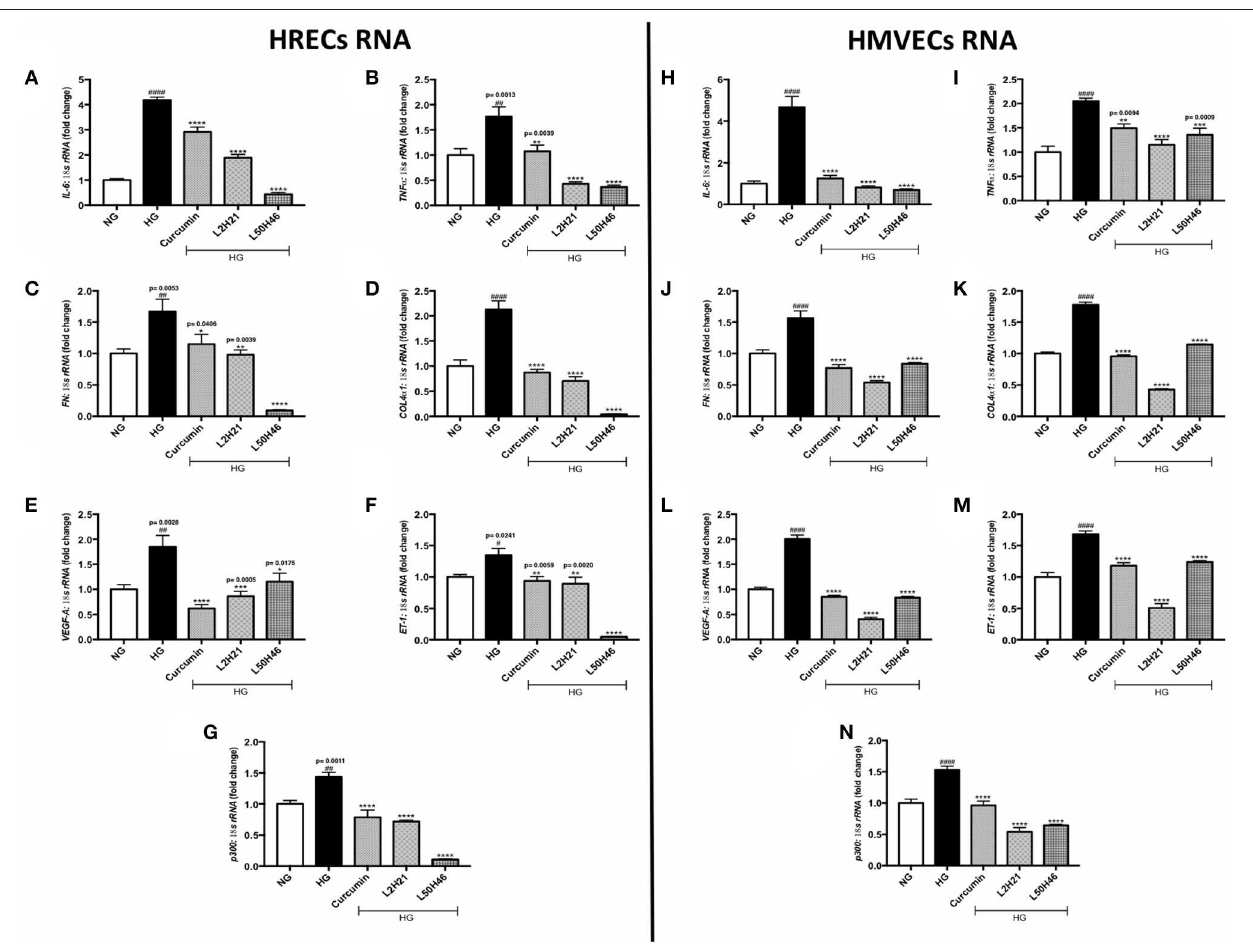
FIGURE 1 | Curcumin analogs significantly reduced gene expressions associated with glucose-induced vascular damage in vitro. Left panel: RT-qPCR analyses showing increased mRNA levels of (A) IL-6 , (B) TNF- α , (C) FN , (D) COL4 α 1 , (E) VEGF-A , (F) ET-1 , and (G) p300 in HRECs exposed to HG for 48h. The administration of curcumin or its analogs (1-h pre-treatment) was able to dampen the glucose-induced levels of these transcripts. Right panel: RT-qPCR analyses showing elevated mRNA levels of (H) IL-6 , (I) TNF- α , (J) FN , (K) COL4 α 1 , (L) VEGF-A , (M) ET-1 , and (N) p300 in HMVECs exposed to HG for 48h. Similar to HRECs, HMVECs treated with curcumin or its derivatives also had significantly lower levels of high glucose-associated molecules [data expressed as a ratio to 18S ribosomal RNA (mean ± SEM); normalized to NG; # significance between NG vs. HG; *significance between HG vs. Treatment group; * , # P < 0.05, ** , ## P < 0.01, *** , ### P < 0.001, and **** , #### P < 0.0001; n = 6 from three independent experiments and performed in triplicates; NG (normal glucose) = 5mM D-glucose; HG (high glucose) = 25mM D-glucose; data analyzed by ANOVA followed by Tukey’s post-hoc